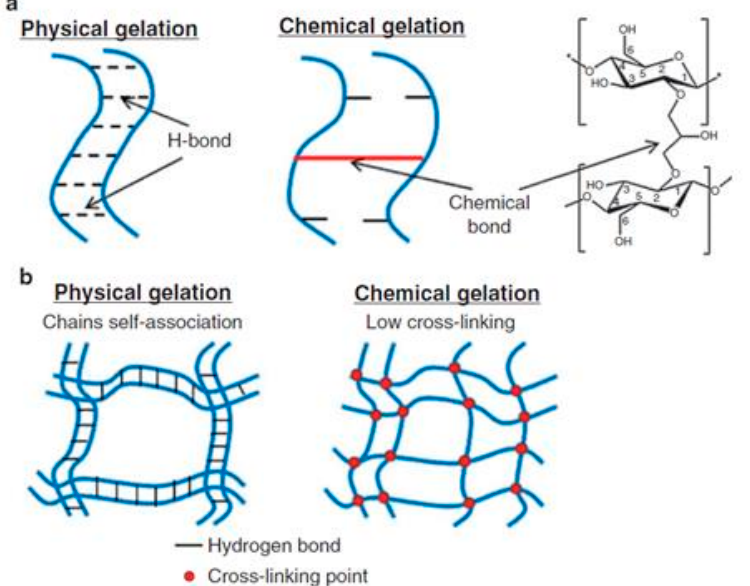
Figure 6. ( a ) A sketch of network formation in cellulose solutions: physical gelation via self-association of chains and chemical cross-linking; ( b ) a schematic presentation of the structures of physical and chemical cellulose gels. [70].